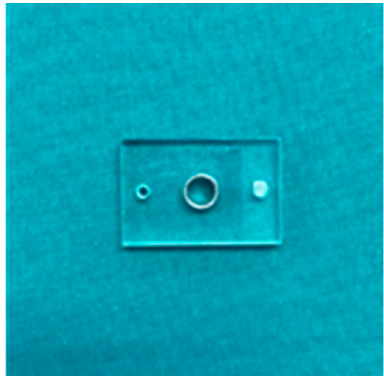
Figure 2. Template to simulate a surgical guide in plexiglass.